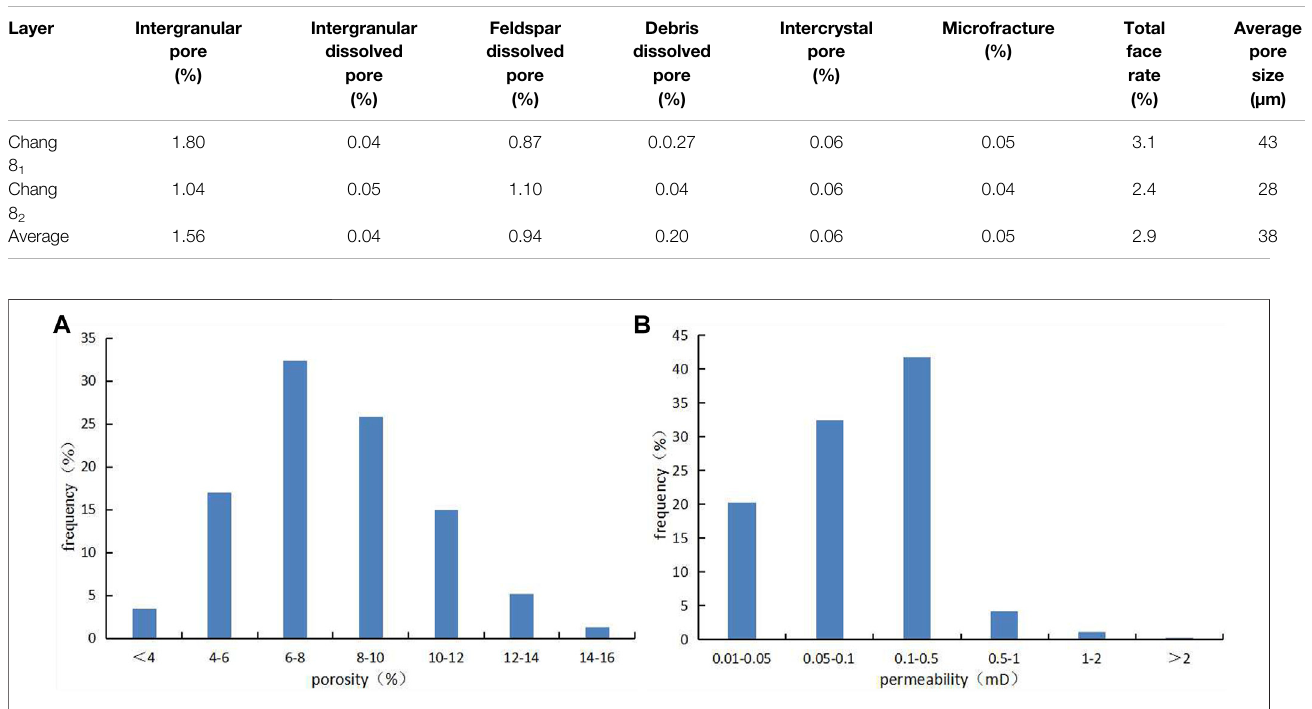
FIGURE 4 | Frequency distribution of porosity (A) and permeability (B) of Chang 8 reservoir in the study